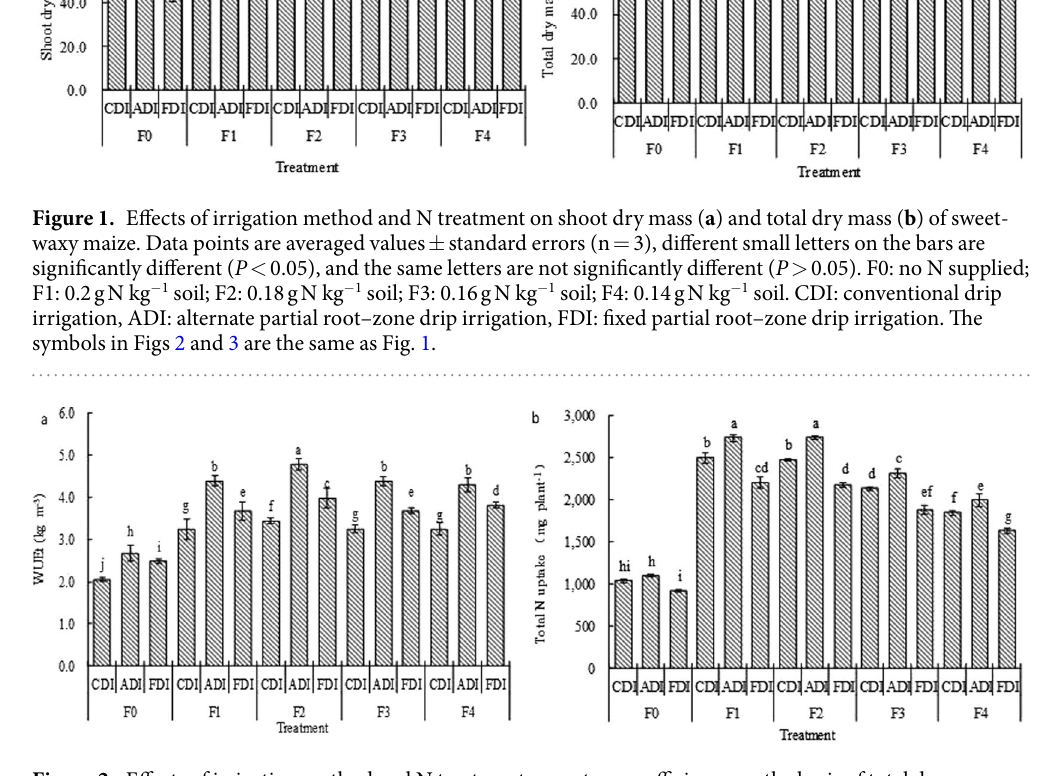
Figure 2. Effects of irrigation method and N treatment on water use efficiency on the basis of total dry mass (WUEt) ( a ) and total N uptake ( b ) of sweet-waxy maize. Data points are averaged values ± standard errors (n = 3), different small letters on the bars are significantly different ( P < 0.05), and the same letters are not significantly different ( P > 0.05).